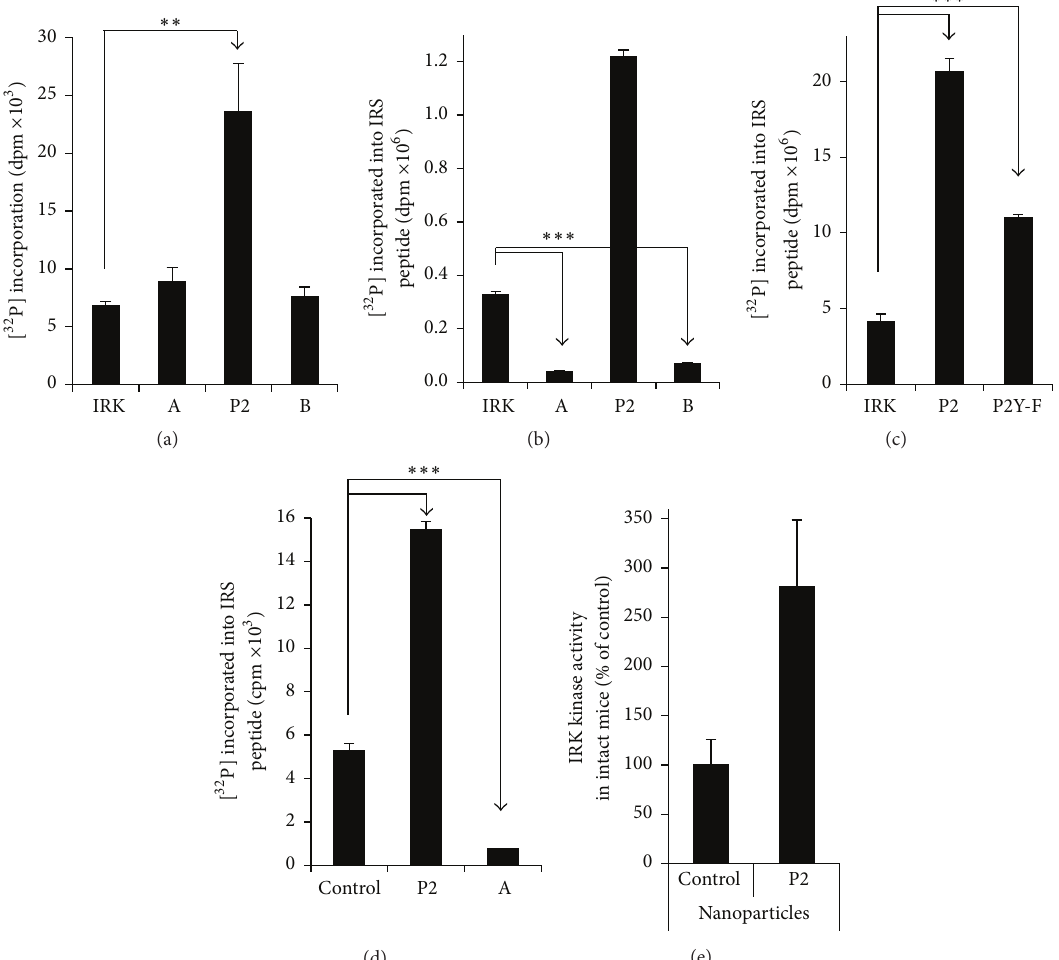
Figure 4: P2 activation of IRK. (a) P2 stimulate IRK autophosphorylation in vitro . IRK was incubated in vitro with 20 𝜇 M of peptide P2 (KYCCSRK), peptide-A (KKRILHC), or peptide-B (KRNRYLSF) and [ 32 P]-ATP. The [ 32 P] incorporation was quantified as described